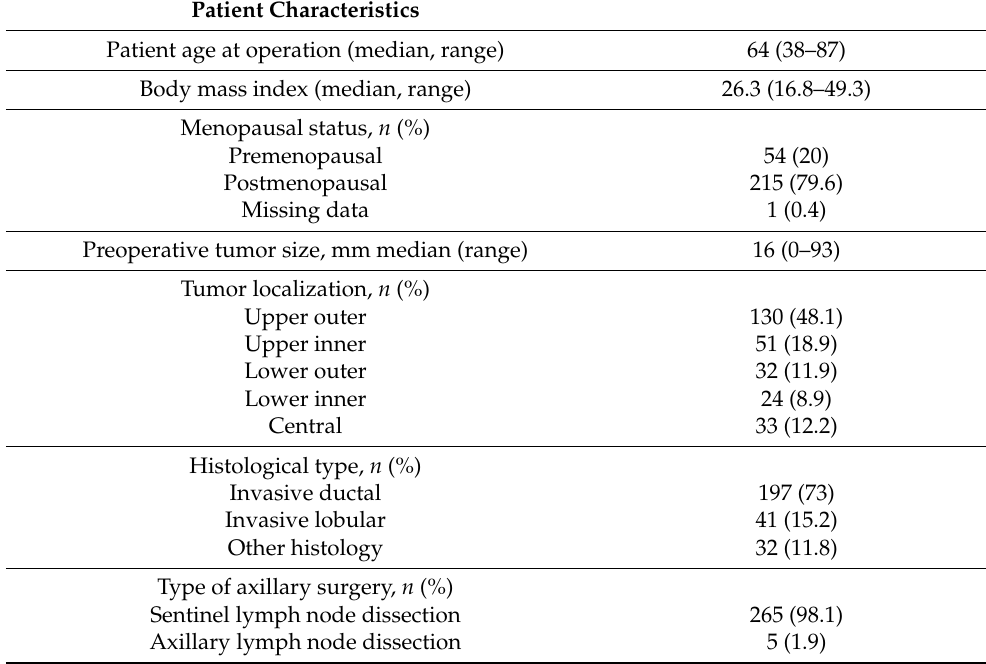
Table 1. Patient and tumor characteristics in women undergoing breast-conserving surgery and sentinel lymph node